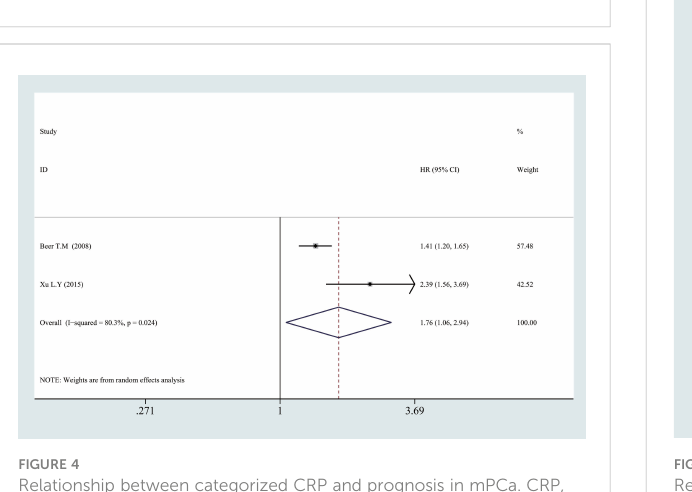
FIGURE 3 Forest plot of log CRP and prognosis in prostate cancer from fi xed- effects analysis. CRP, C-reactive protein.